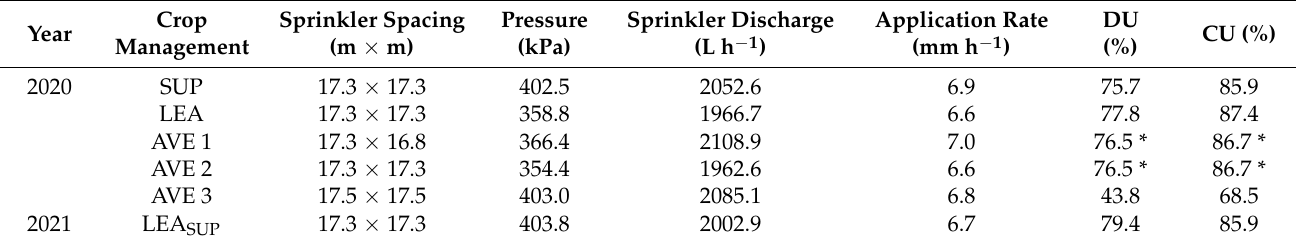
Table 2. Characterization of monitored irrigation